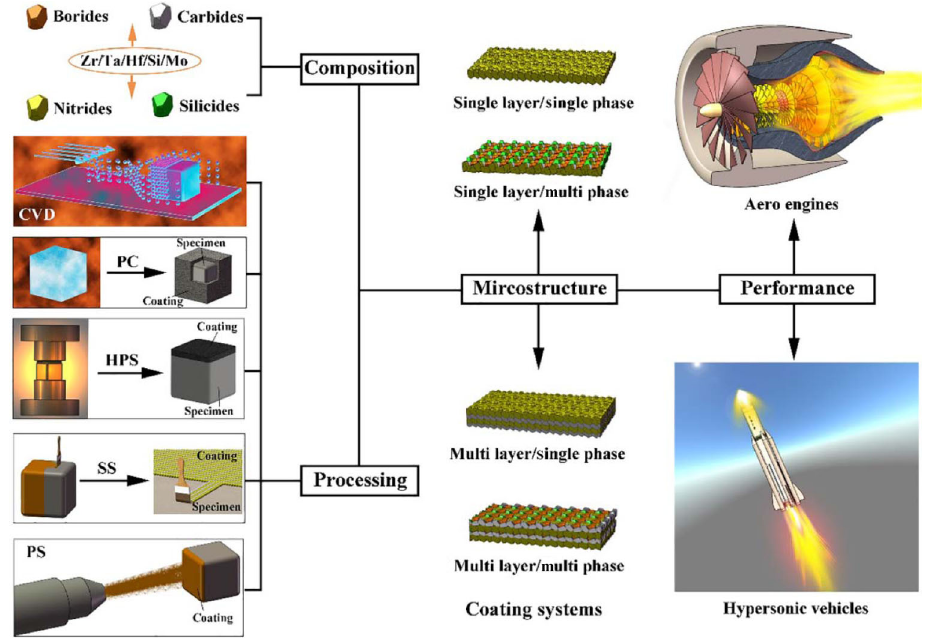
Fig. 30 Schematic diagram of the composition, processing, microstructure, and application of the UHTC